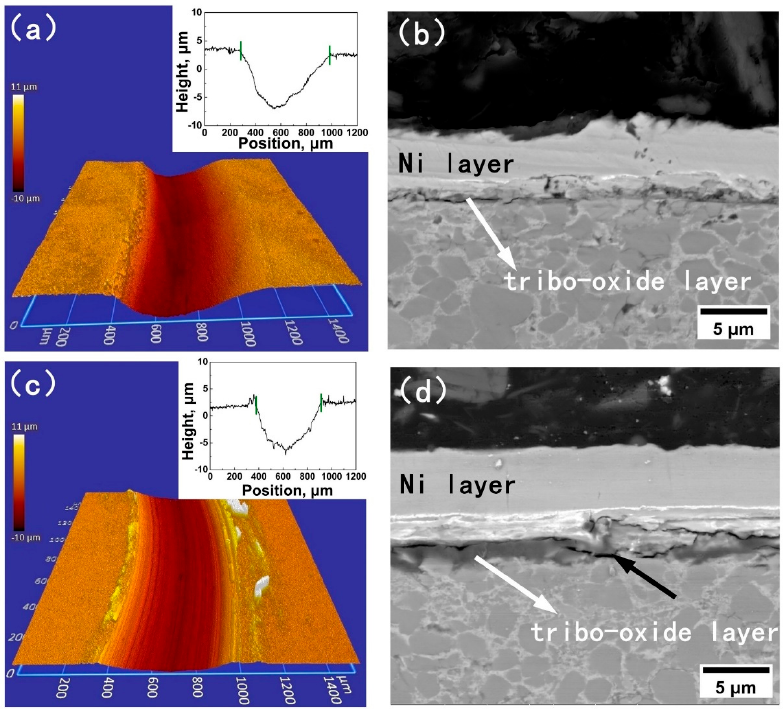
Figure 12. ( a ) Depth profile and ( b ) cross-sectional SEM image of the wear scar of the as-sprayed coating after HT wear test, ( c , d ) those of the 192 h-annealed coating. The black arrow in ( d ) points out a crack.